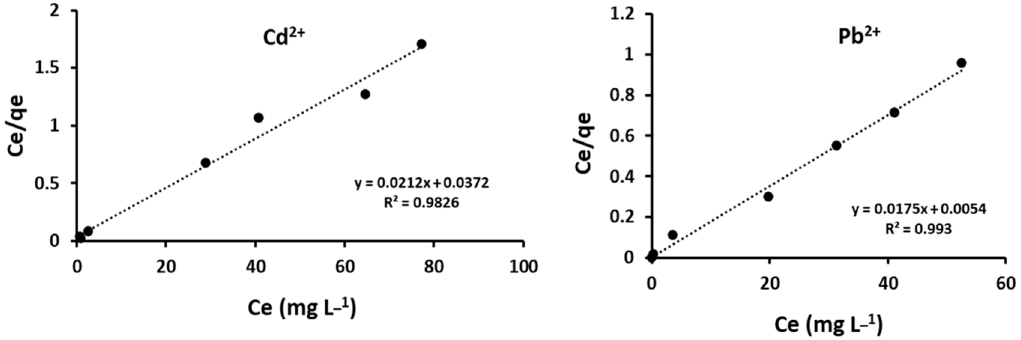
Figure 9. Langmuir isotherm model for Cd 2+ and Pb 2+ using BPAC@Al 2 O 3 @chitosan. Table 2. Adsorption isotherm parameters for the Langmuir and Freundlich models. Langmuir Parameters